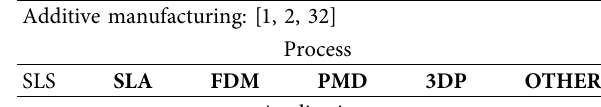
Table 2: Different AM processes and